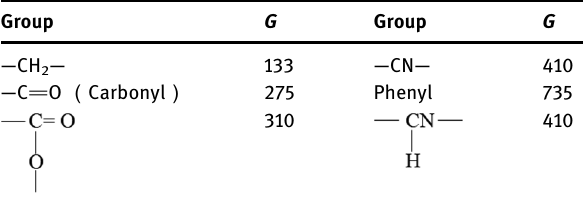
Table 2: Polyamide - link chemical groups ’ molar attraction constant G ( 2.04 × 10 − 3 J 1/2 · m 2/3 ) at 25°C ( 17 )